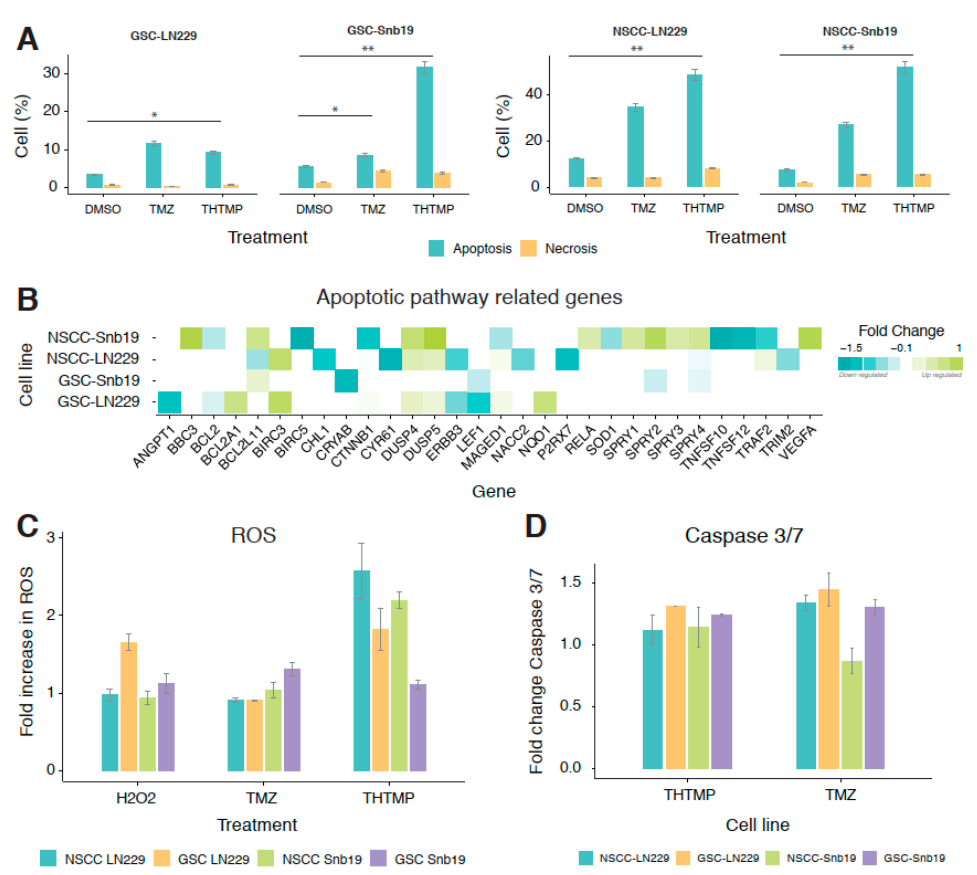
Figure 3. THTMP induces apoptosis in NSCCs and GSCs. ( A ) Percentage of apoptotic cells and necrotic cells upon THTMP/TMZ treatment at 24 h, stained with Annexin V-FITC/PI. ( B ) The top DEGs which are involved in apoptosis induction on GSCs and NSCCs. The DEGs were color coded that corresponds to the up- and down-expressed genes. ( C ) Effect of THTMP/TMZ on NSCCs and GSCs intracellular ROS production. ( D ) Activity of caspases 3/7 on NSCCs and GSCs in THTMP/TMZ treatment. Fold increase in ROS and caspases 3/7 activity of cells was calculated with triplicates for each condition. The data were normalized against DMSO control (C) and (D). * P < 0.05, ** P < 0.01.